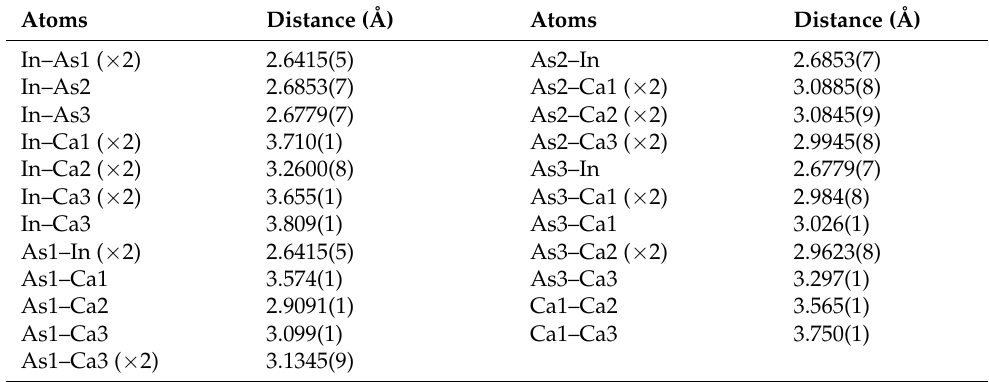
Table 3. Selected interatomic distances (Å) in Ca 3 InAs 3 . Contacts longer than 3.9 Å are not shown. Atoms Distance (Å)